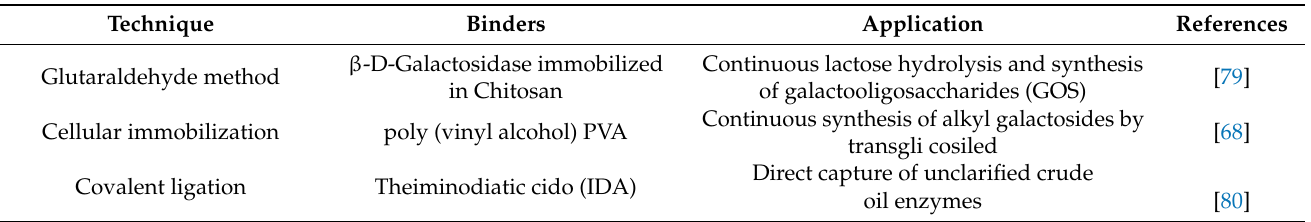
Table 5. Cryogel functionalization